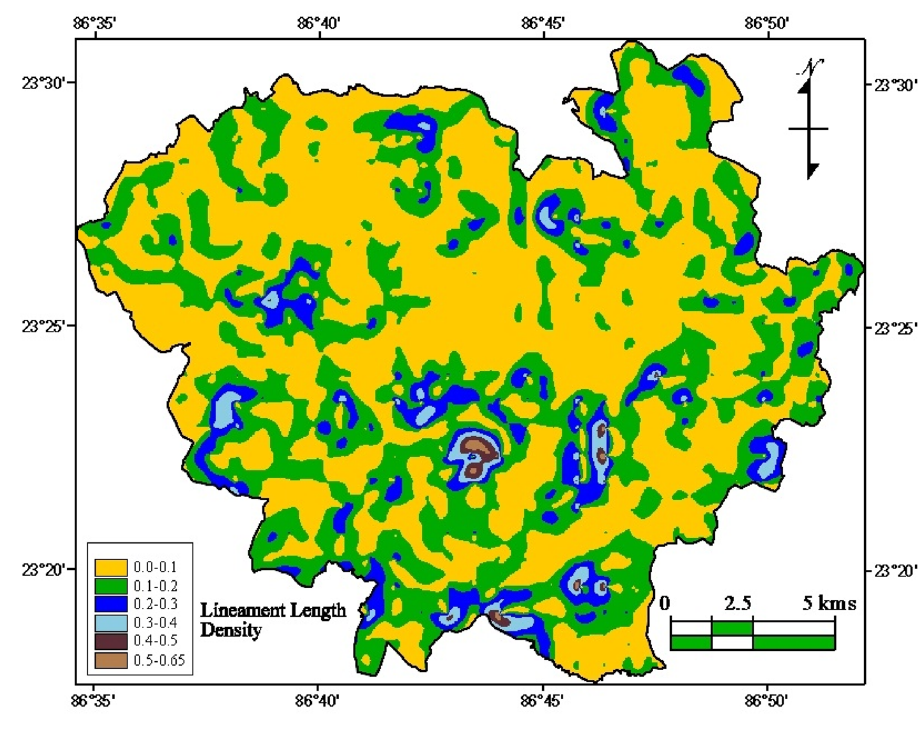
Fig. 8 Lineament length density map of the study